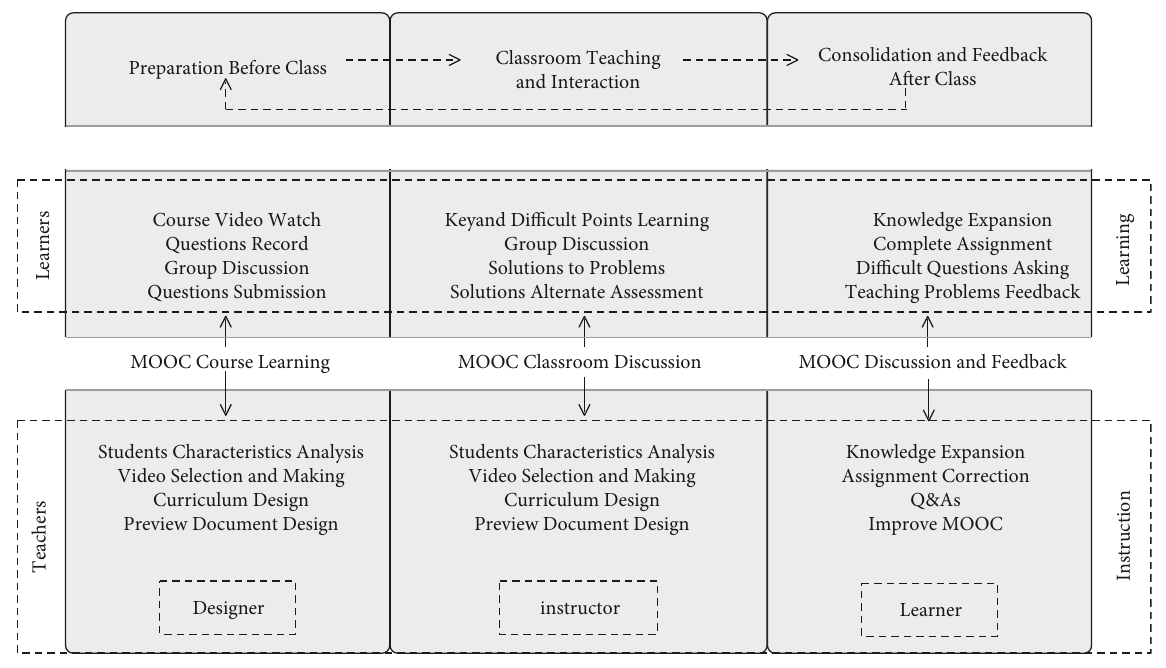
Figure 1: Curriculum teaching